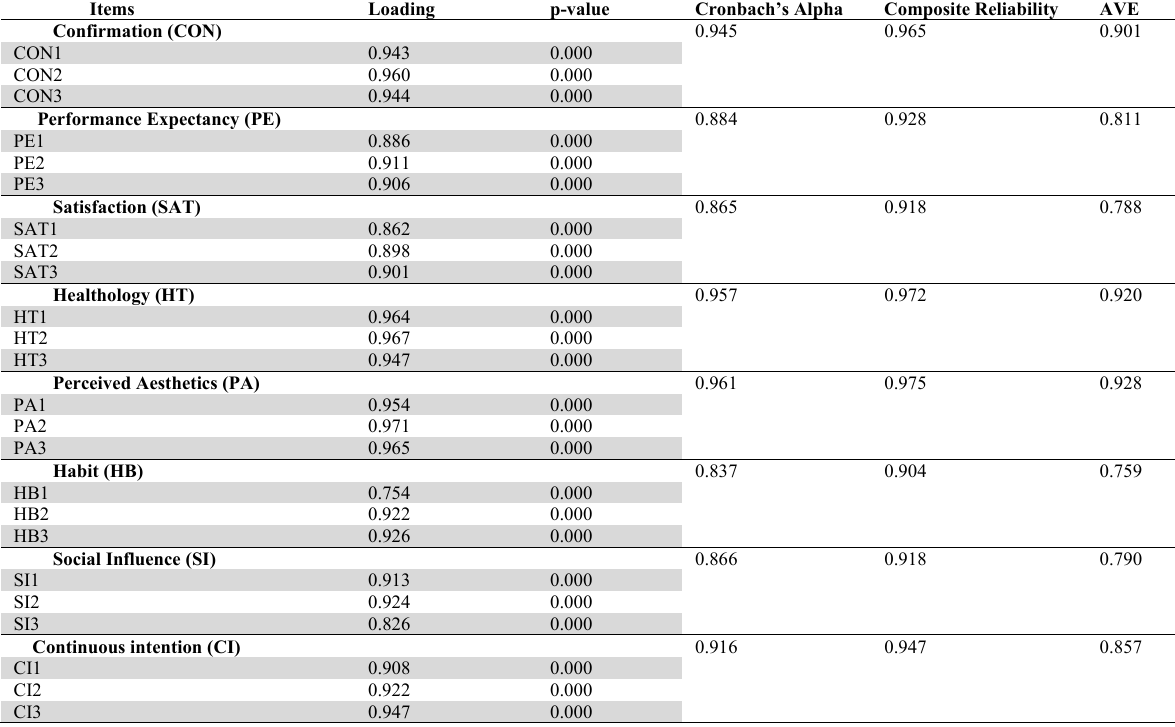
Items loading, p-value, Cronbach’s alpha, Composite reliability, and AVE Items